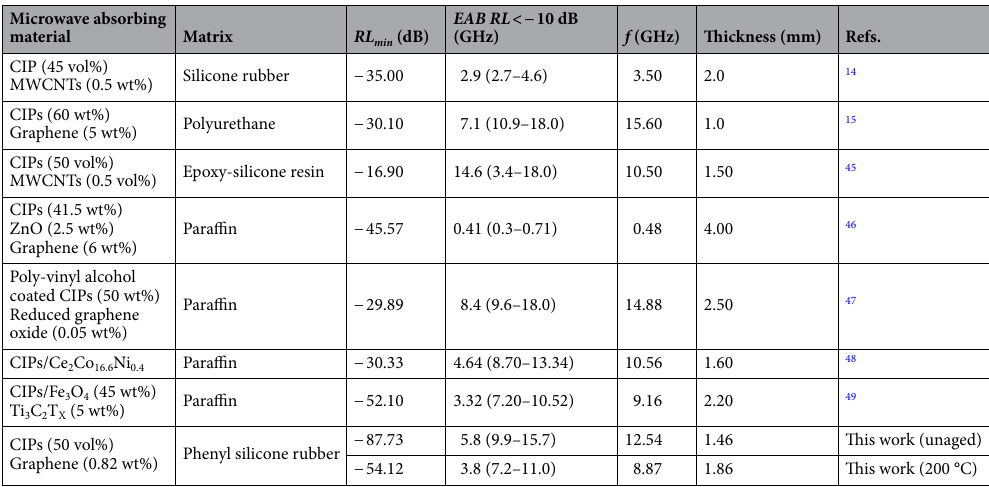
Table 1. The comparison of the MPVQ/CIPs/GR composites with other microwave-absorption composites incorporated with CIPs.